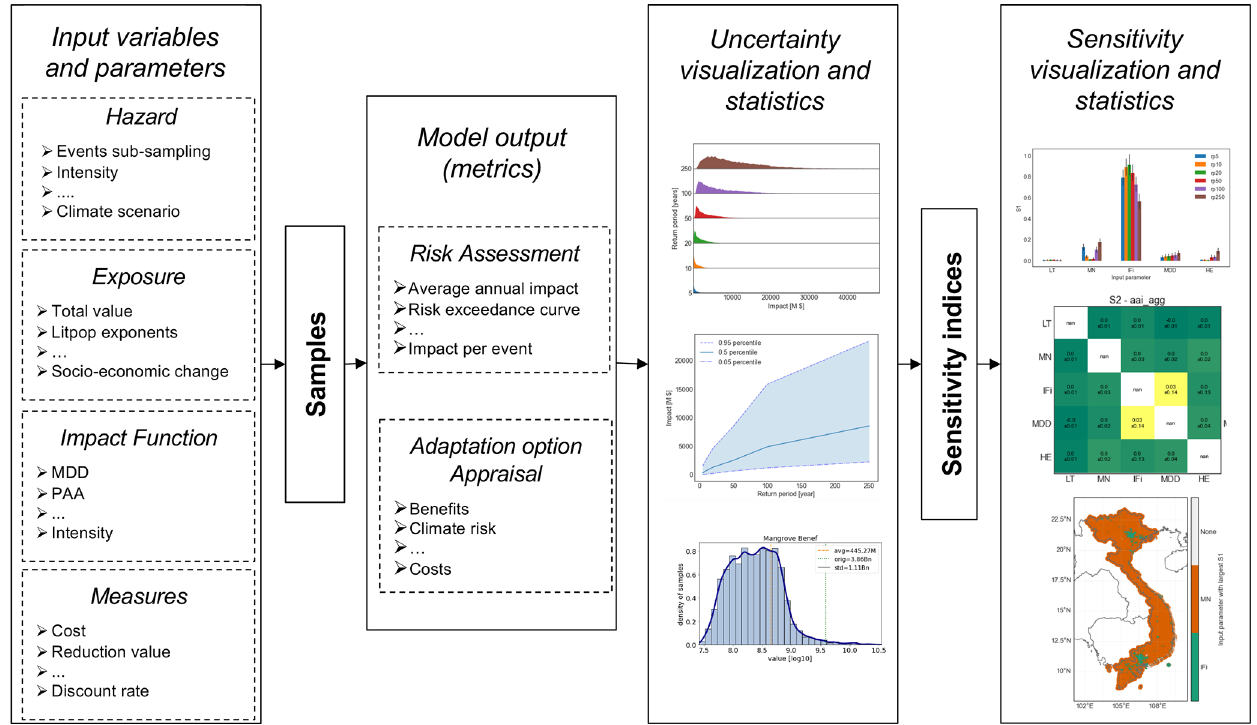
Figure 1. The workflow for uncertainty and sensitivity analyses with the unsequa module in CLIMADA consists of six steps (from left to right). (1) Define the input variables (hazard, exposure, impact function, adaptation measure) and their uncertainty input parameters (e.g. hazard intensity, total exposure value, impact function intensity, measures cost). (2) Generate the input parameter samples. (3) Compute the model output metrics of interest for risk assessment and appraisal of adaptation options for each sample using the CLIMADA engine. (4) Analyse the obtained uncertainty distributions with statistical tools and provide a set of visualizations. (5) Compute the sensitivity indices for each input parameter and each output metric. (6) Analyse the sensitivity indices by means of statistical methods and provide different